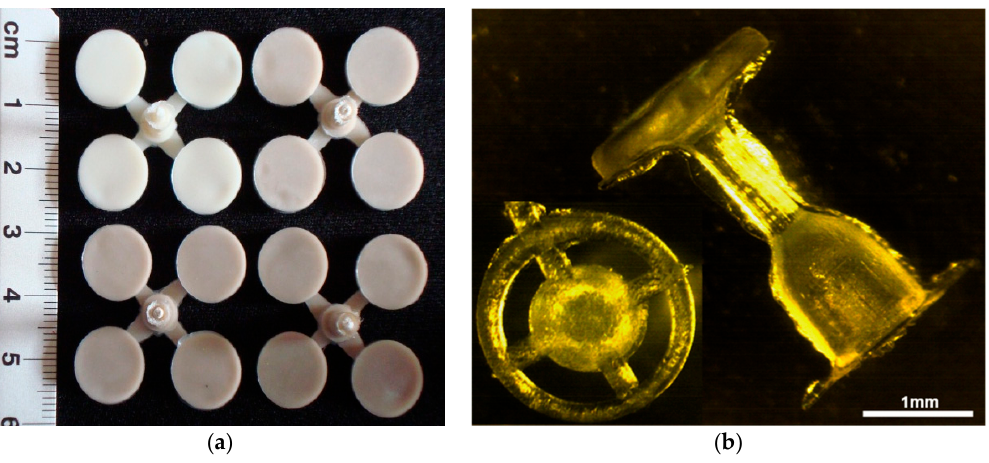
Figure 7. ( a ) Samples for in vitro tests; ( b ) middle ear prostheses.